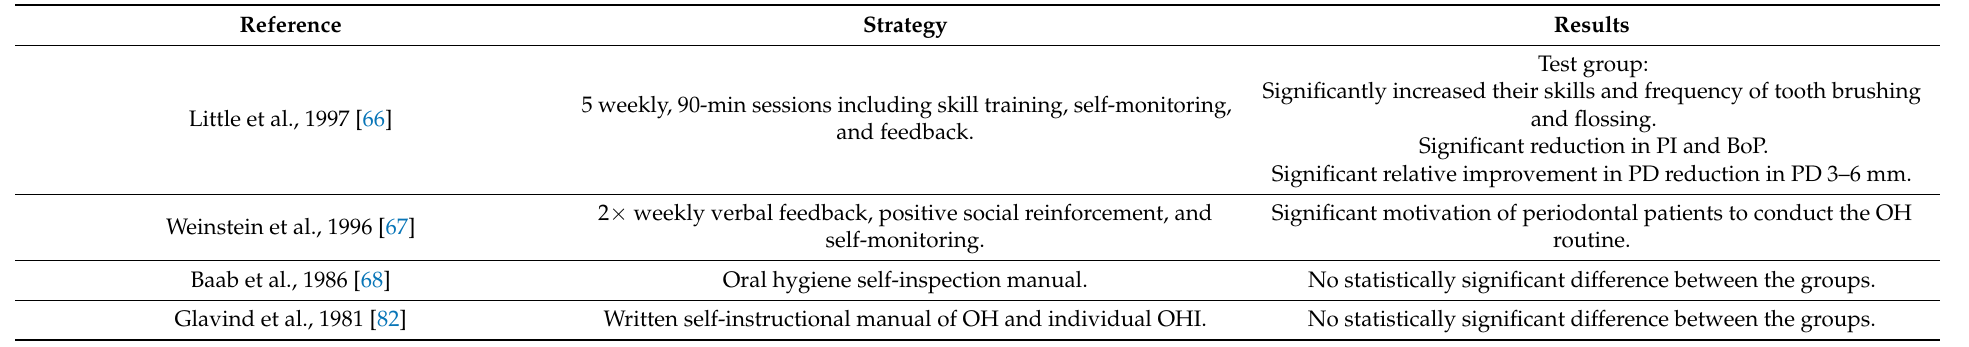
Table 4. Summary of the strategy and results of the included studies exploring the impact of psychological models of health-related behavior on the behavior and periodontal status of patients with periodontal